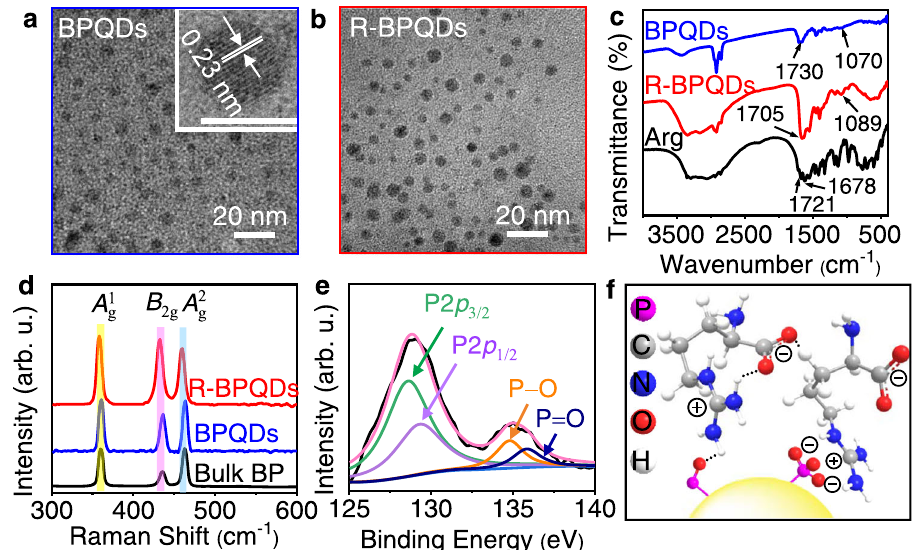
Fig.1|Structuralandchemicalcharacterizationbefore(BPQDs,blue)andafter Arg modi fi cation (R-BPQDs, red). a , b TEM images. Inset in ( a ) HRTEM image of BPQDs; scale bar: 5nm. c FTIR spectra with Arg as reference (black). d Raman spectra with bulk BP as reference (black). e Experimental XPS data (black) of